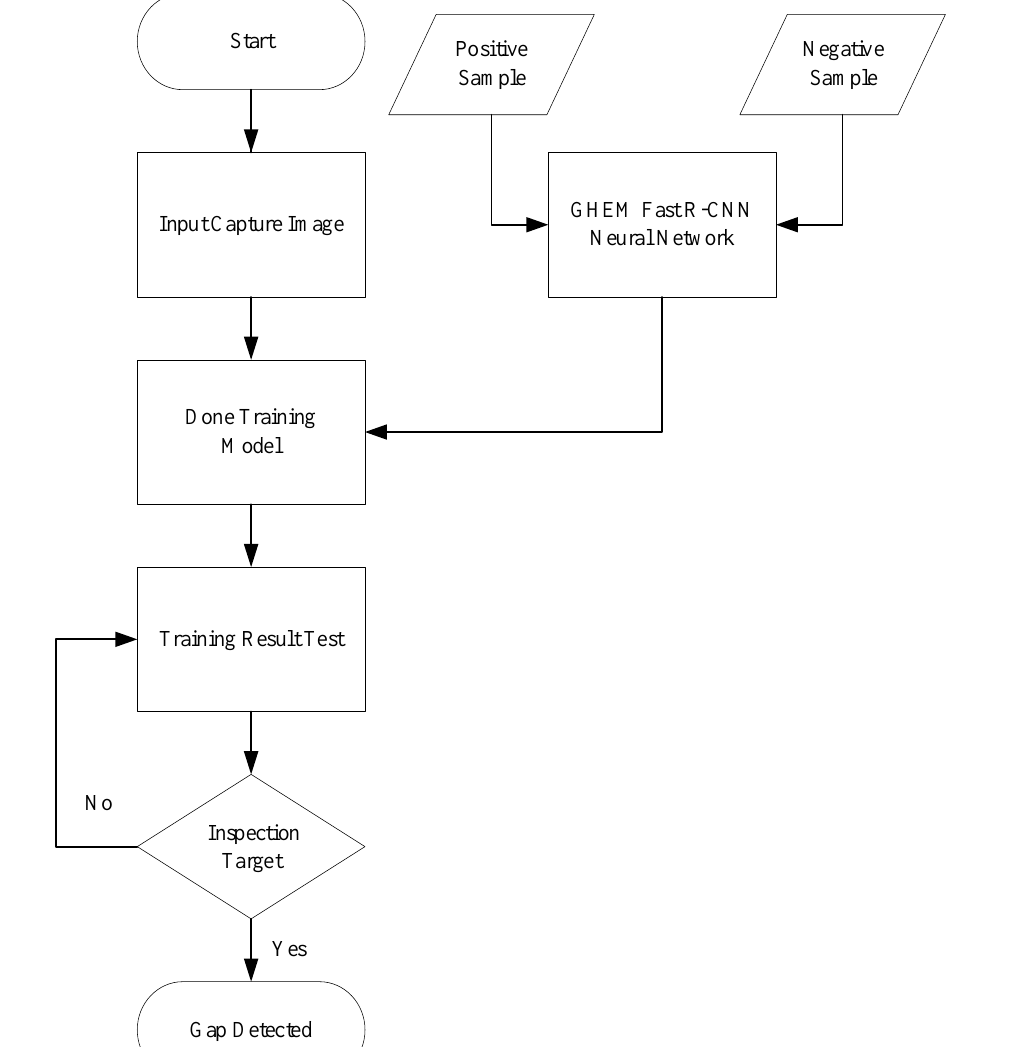
Figure 9. Class neural network training and detection process.